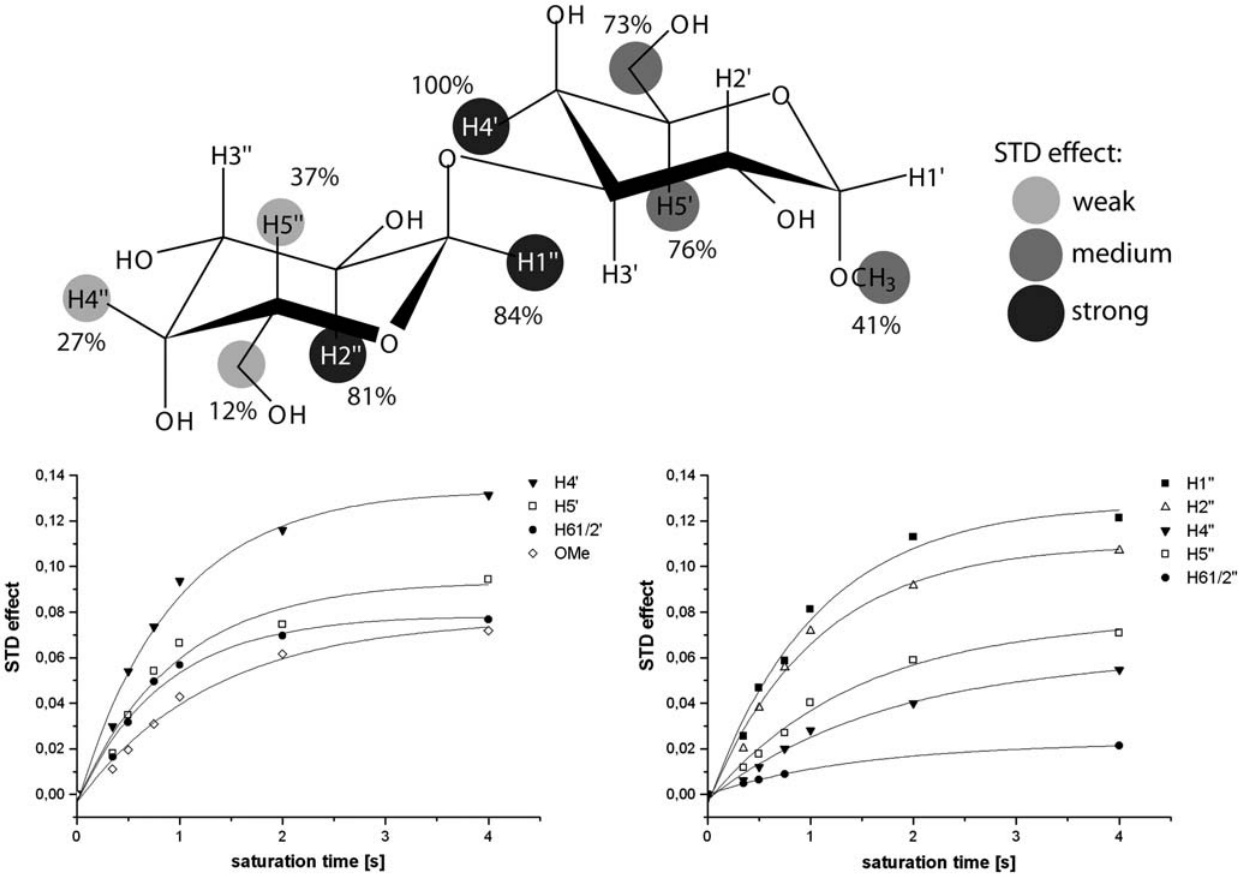
Figure 7. Binding epitope of Gal a 3Gal a OMe binding to rNB2 VLPs (top) as derived from STD build-up curves (bottom). Greyscale circles encode the relative size of the saturation transfer and reflect the vicinity to protons in the binding pocket of rNB2 VLP. The larger the saturation transfer, the closer are the ligand protons to protons of the VLP binding pocket. From the Figure it is seen that the region around the glycosidic linkage is essential for recognition by the VLPs.